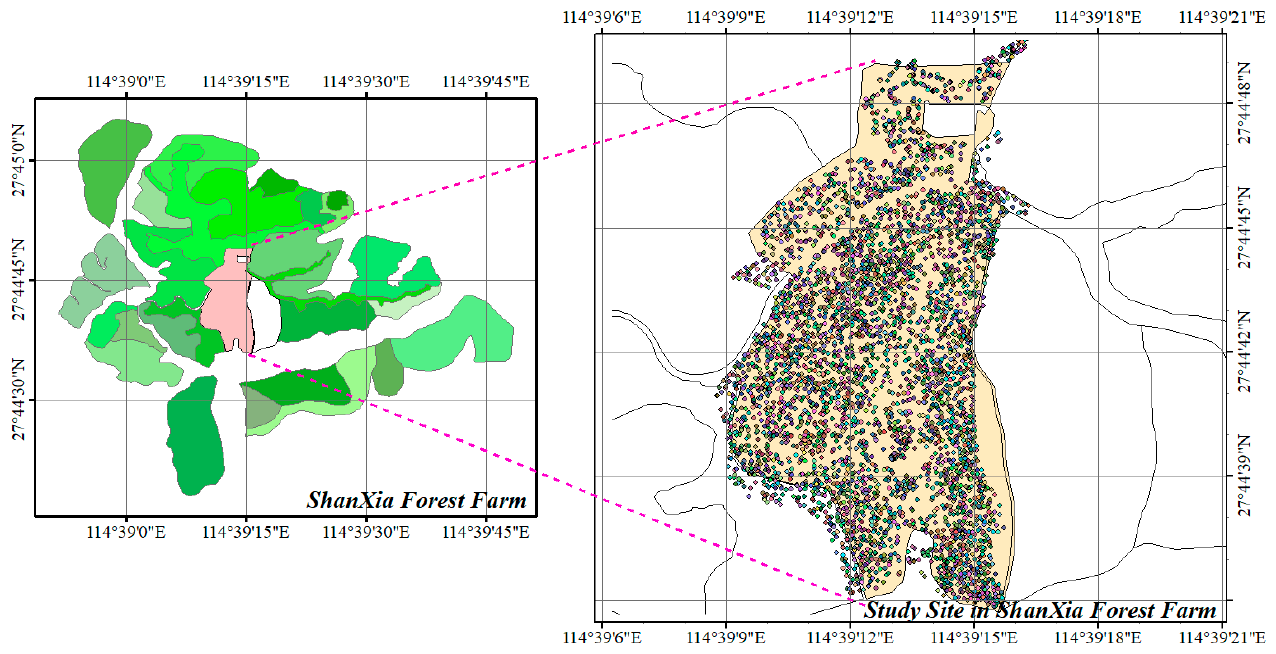
Figure 1. Location of our study site in a subtropical area of China. Notes: the pink area in the left map represents the study region at ShanXia Forest Farm; colorful points in the right map represent different tree species in the study